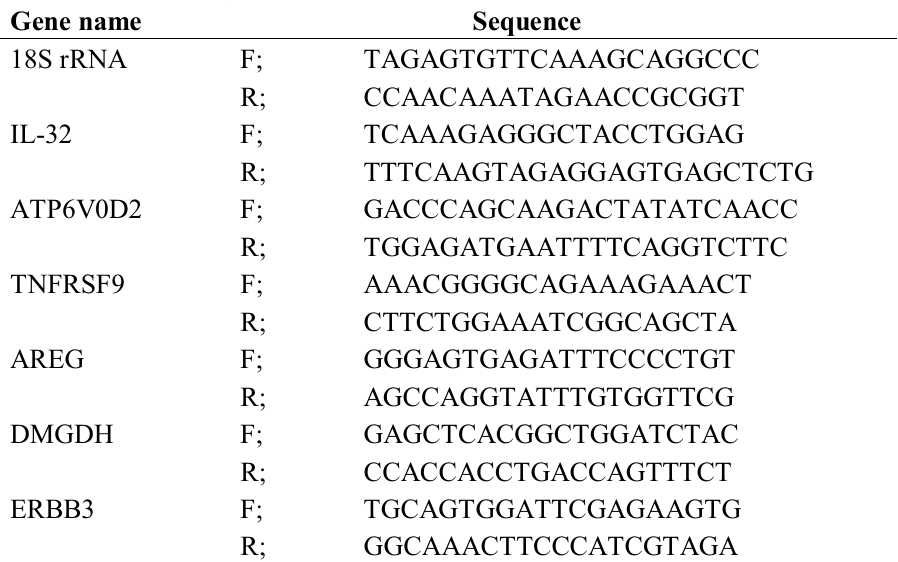
Table 1. Primers used in this